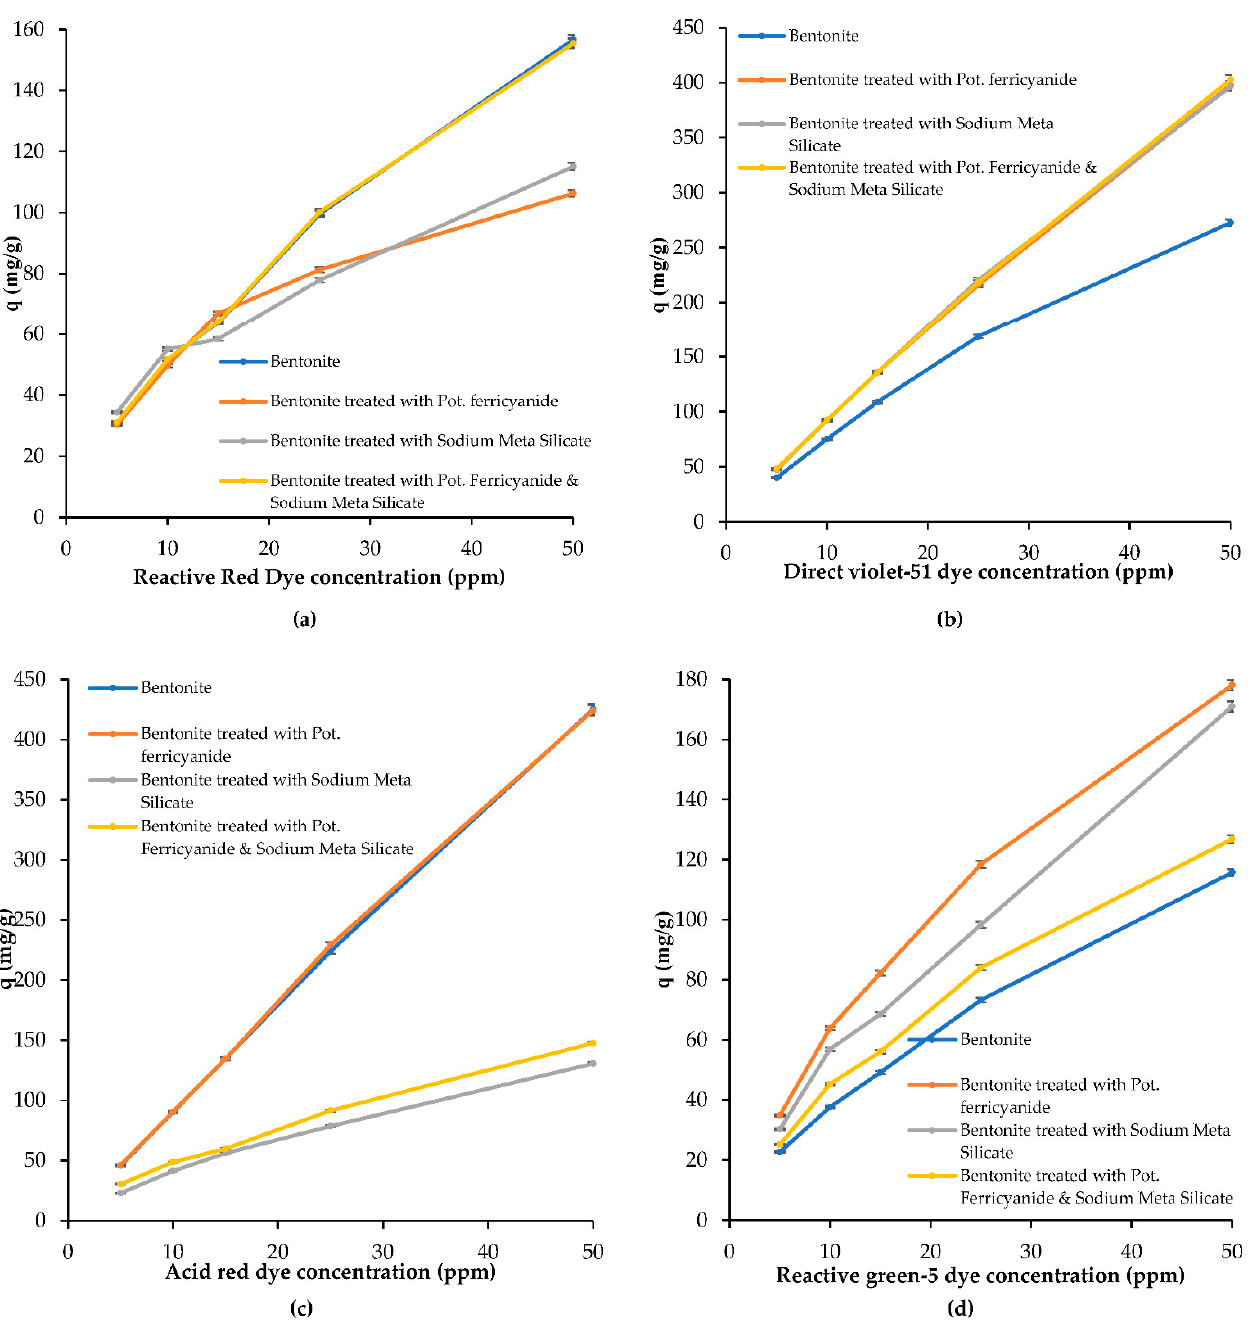
Figure 2. Adsorption capacities of adsorbents for ( a ) Reactive red, ( b ) Direct violet-51, ( c ) Acid red, and ( d ) Reactive green-5 dyes at different concentrations.